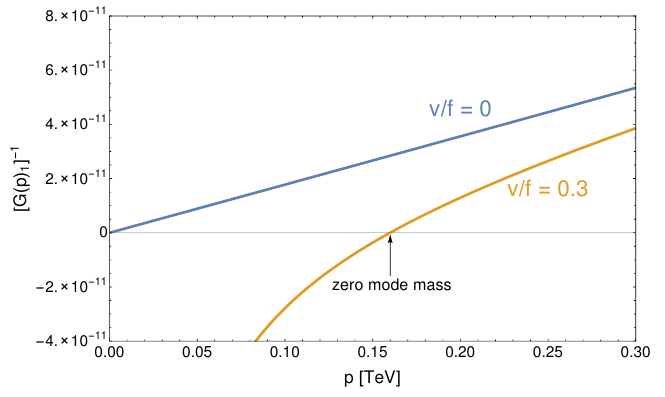
Figure 18 . Spectral density for c L = 0 : 3 ; c R = (cid:0) 0 : 1 ; M 1 = 0 : 6 ; M 2 = 0.